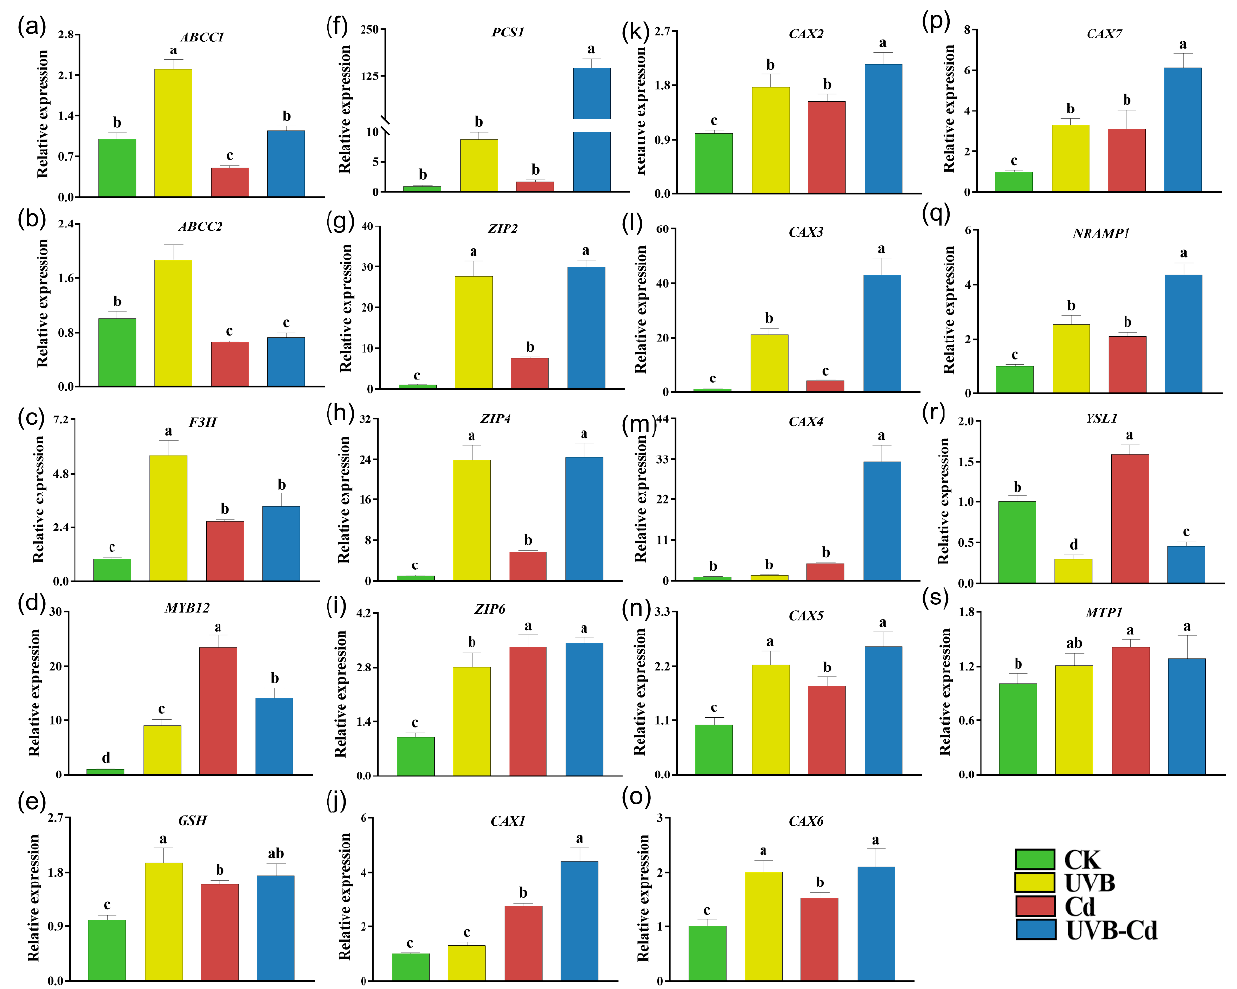
Figure 7. Relative expression of genes related to Cd uptake, transport, and detoxification in poplar root under different treatments. The expression levels of ABCC1 ( a ), ABCC2 ( b ), F3H ( c ), MYB12 ( d ), GSH ( e ), PCS1 ( f ), ZIP2 ( g ), ZIP4 ( h ), ZIP6 ( i ), CAX1 ( j ), CAX2 ( k ), CAX3 ( l ), CAX4 ( m ), CAX5 ( n ), CAX6 ( o ), CAX7 ( p ), NRAMP1 ( q ), YSL1 ( r ), and MTP1 ( s ) in poplar root ( n = 5 plants for each treat- ment). Different letters represent significant differences among four treatment groups ( p < 0.05).